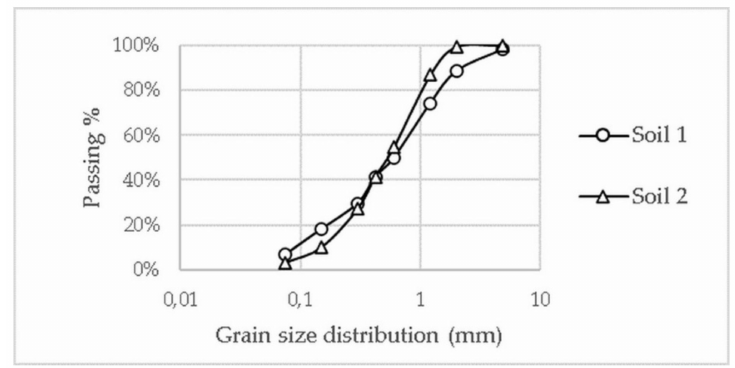
Figure 5. Grain size distribution graph of samples from Soils 1 and 2 [39].